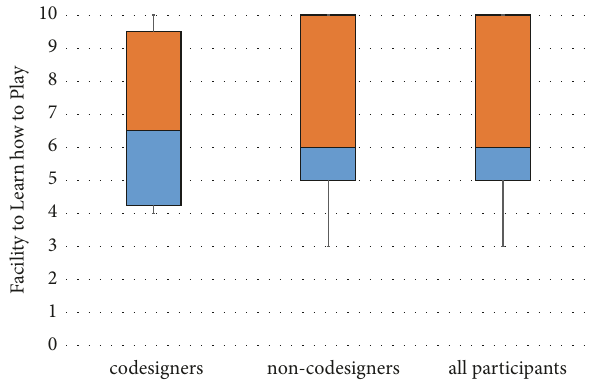
Figure 15: Answers from topic 16 of Table 9: this topic measures the facility of users on learning how to play the tested game.